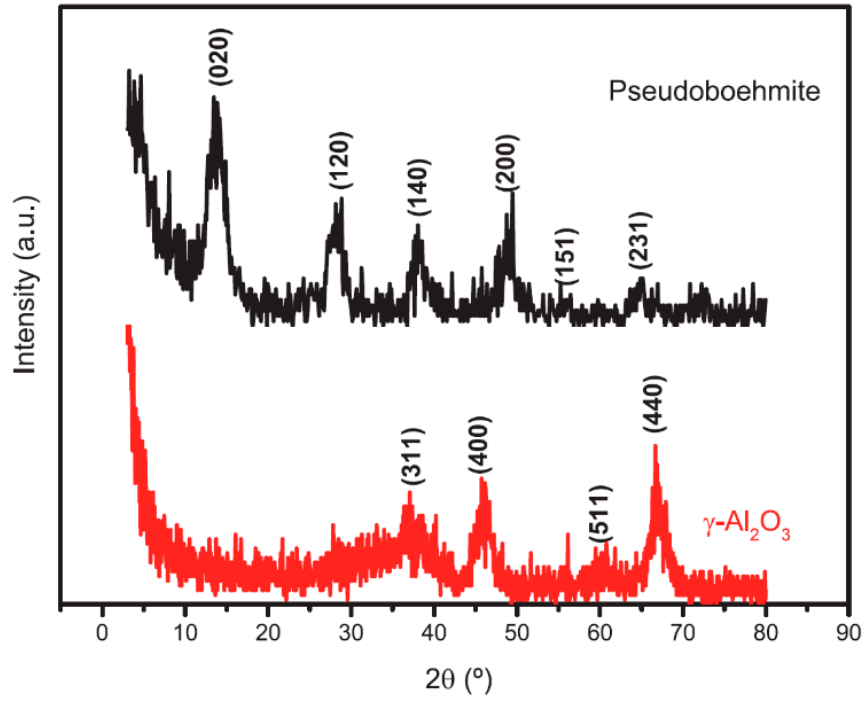
Figure 1. Pseudoboehmite and γ -Al 2 O 3 powder XRD patterns.